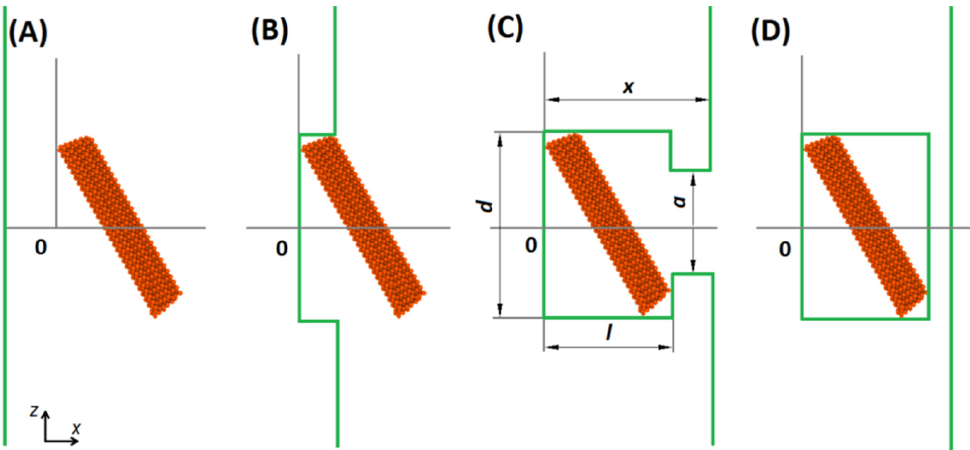
Figure 3. Stages of dislocation–precipitate interaction: ( A ) dislocation free slip in front of θ ’; ( B ) dislocation looping around θ ’; ( C ) closing the Orowan loop; ( D ) dislocation slip behind θ ’.